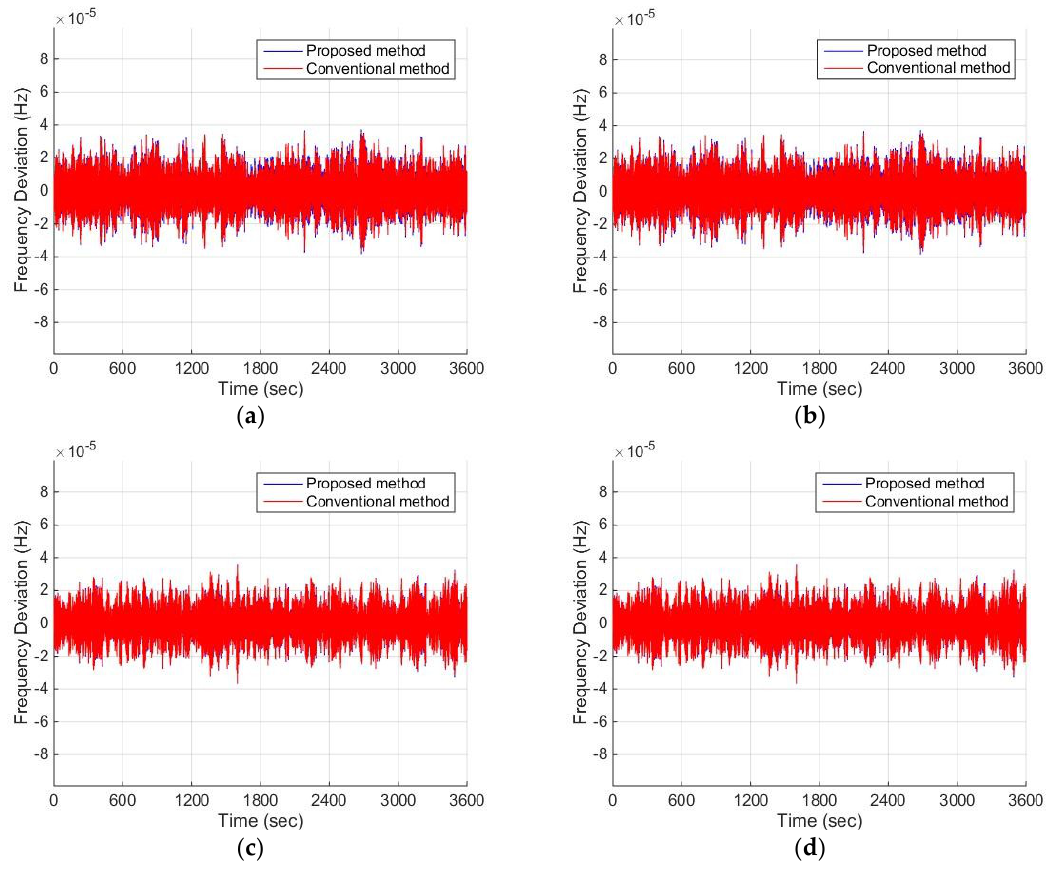
Figure 9. Frequency deviation of MG 1 : ( a ) without disturbance or uncertainties; ( b ) with external disturbance; ( c ) with system parameter uncertainties; and ( d ) with external both disturbance and system parameter uncertainties.